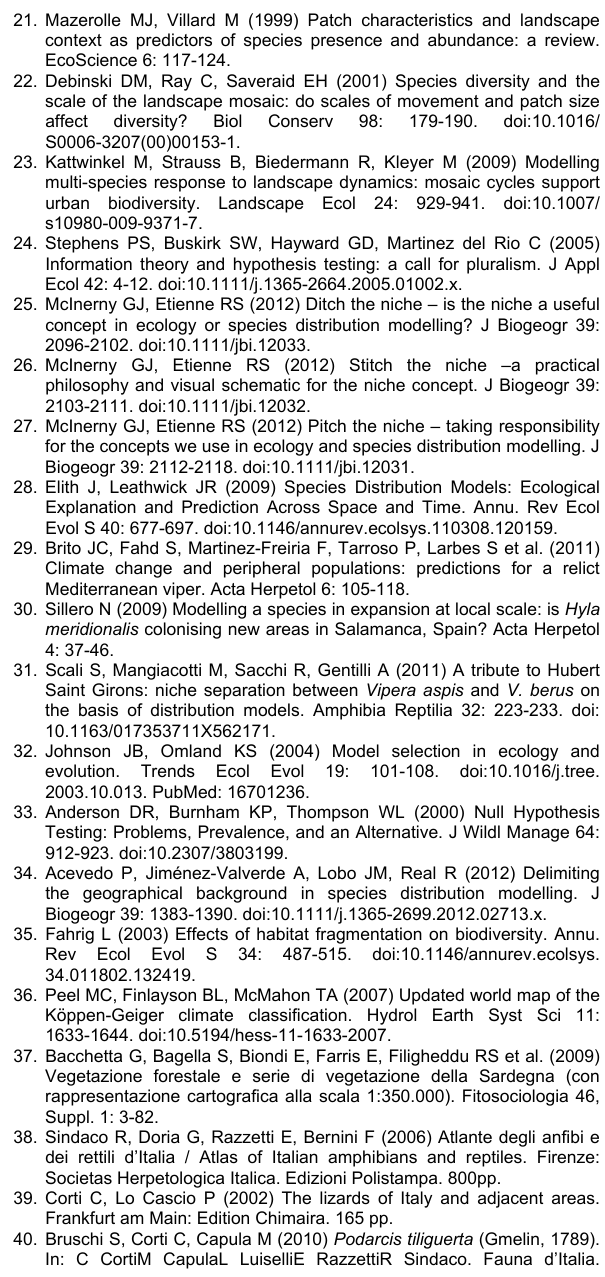
Table S3. Spatial correlations among the final candidate variables.